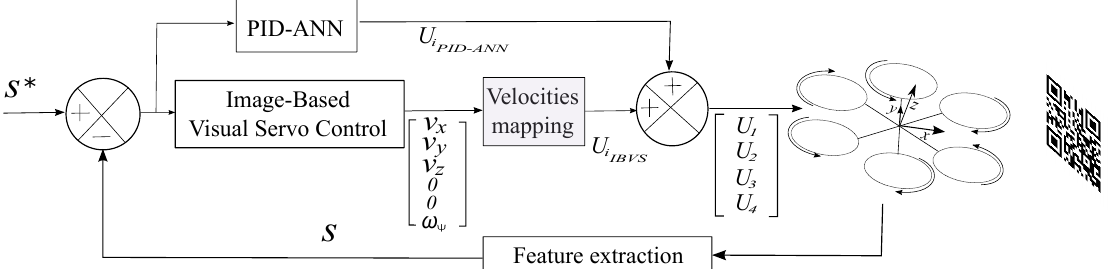
Figure 3. Block diagram of our Image Based Visual Servo (IBVS) control algorithm combined with Artificial Neural Network based PID (PID-ANN). The Artificial Neural Network based PID module consists of four modules (one for each Degree of Freedom). The output of the IBVS block is the velocity vector with angular velocity equal to 0 for roll and pitch since we assume the pattern will never be rotated in those angles. The output of IBVS control block consists of translational velocities v x , v y , v z , which must be mapped to U 2 , U 3 and U 1 , respectively, in order to be added to the PID-ANN output. These U i control actions will be traduced to translational displacement of the robot.